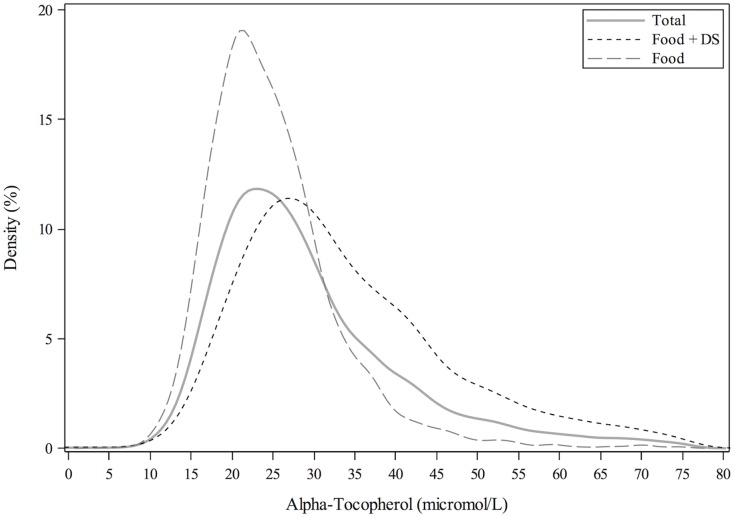
Distribution of serum α-tocopherol concentrations among individuals ≥20y, excluding pregnant or lactating women, stratified by supplement use.Lines represent density (as a percentage) through non-parametric kernel density estimation.